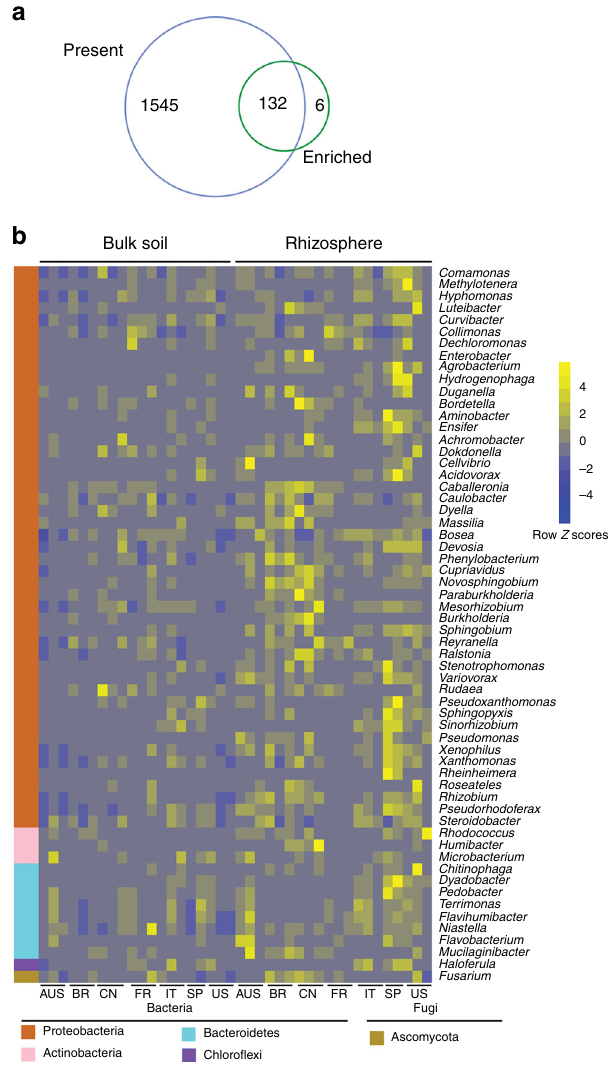
Fig. 3 Characterization of the core citrus rhizosphere microbes. a Venn plot depicting the number of core rhizosphere genera based on the presence rate (>75%) in all samples and the genus enrichment from bulk soil to rhizosphere using metagenomic sequences. b Relative abundances of the 60 most relatively abundant core rhizosphere genera across locations and compartments based on metagenomic data. Scale, relative abundance of genus at row normalization by removing the mean (centering) and dividing by the standard deviation (scaling). The color from blue to yellow represents a relative abundance of each taxa from low to high.